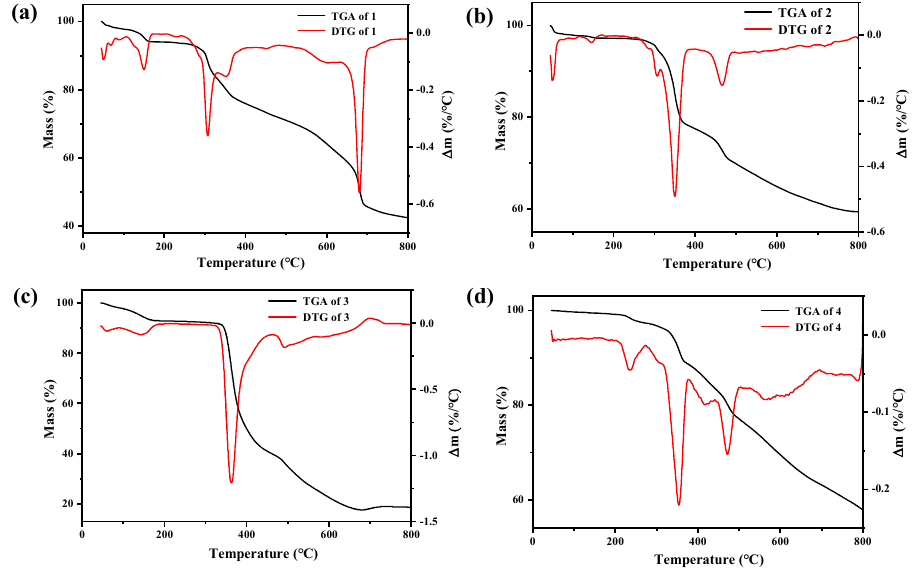
Figure 4. The TG and DTG curve of compounds 1(a) , 2(b) , 3(c) , and 4(d) .